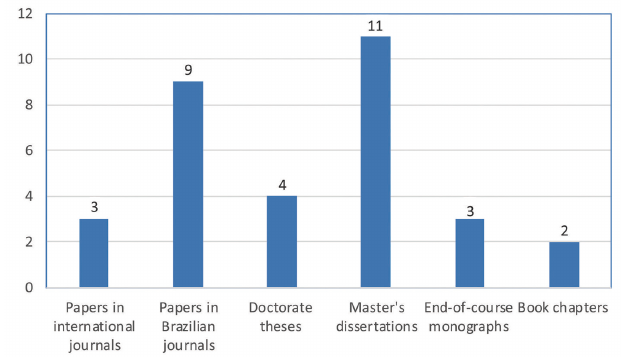
Figure 3 - Studies carried out with Lagoa Salgada as the principal